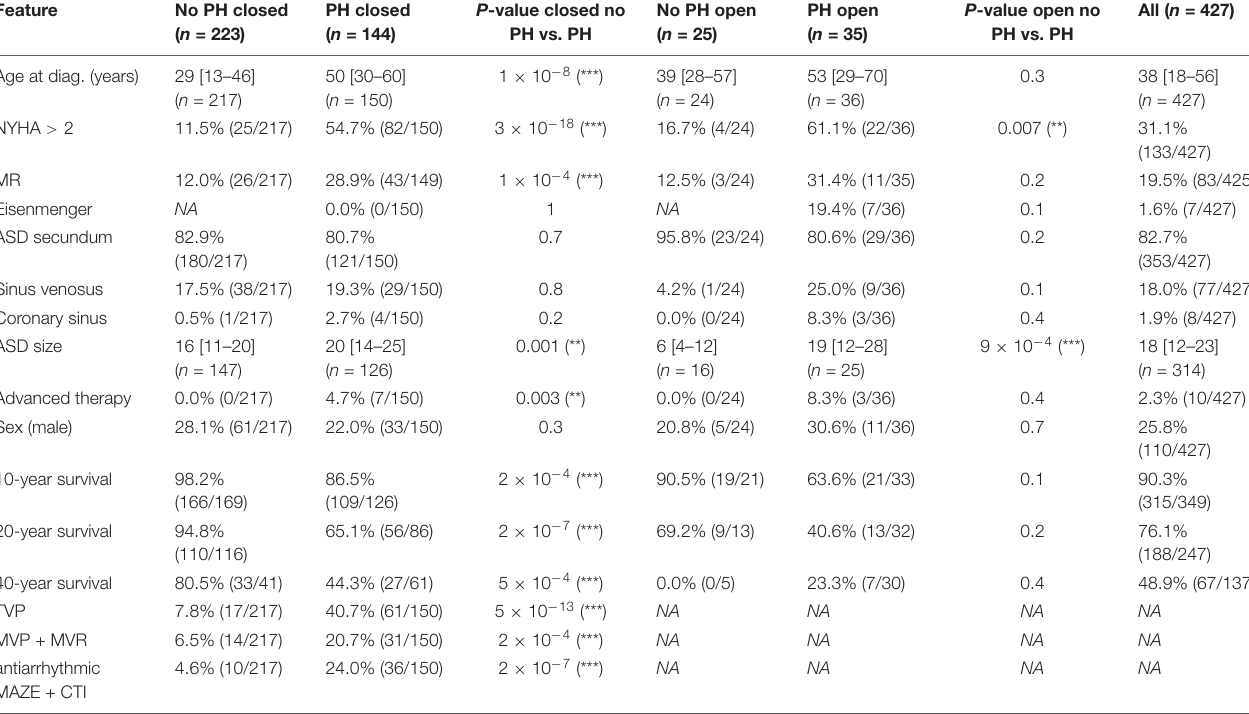
TABLE 1 | Patient